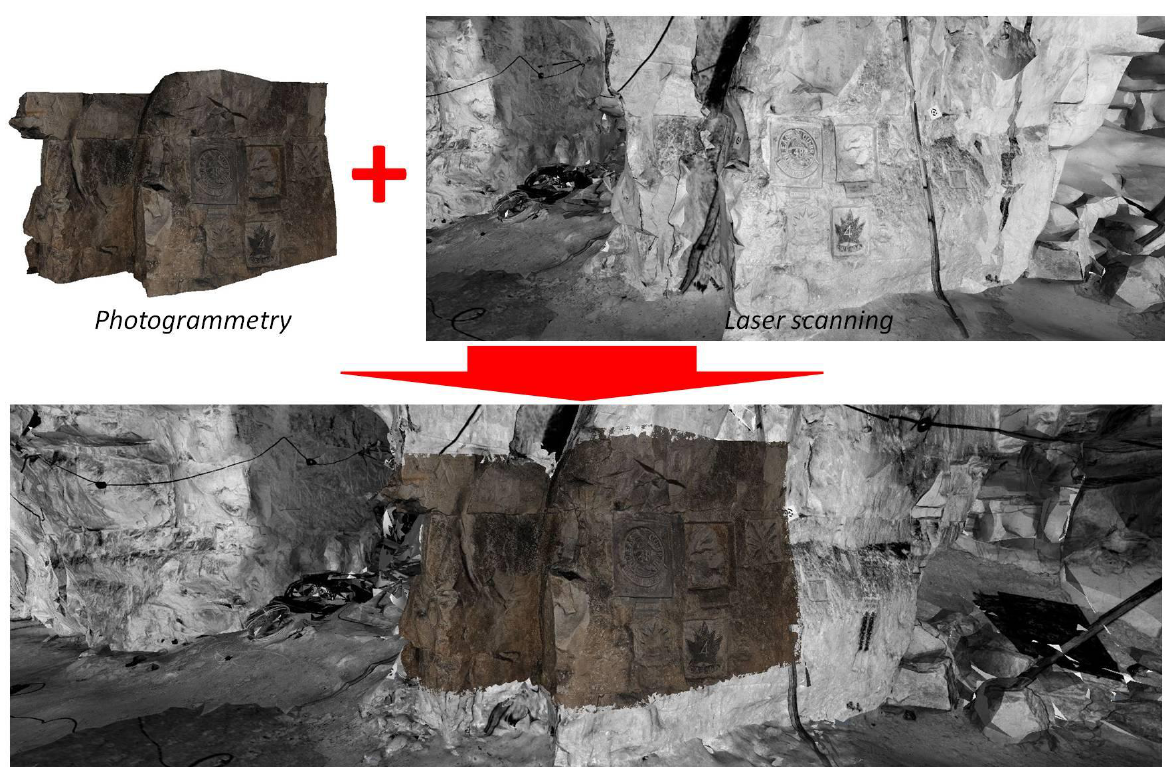
Figure 5. The integration of the detailed photogrammetric 3D model into the global laser scanner 3D model to create a hybrid model.